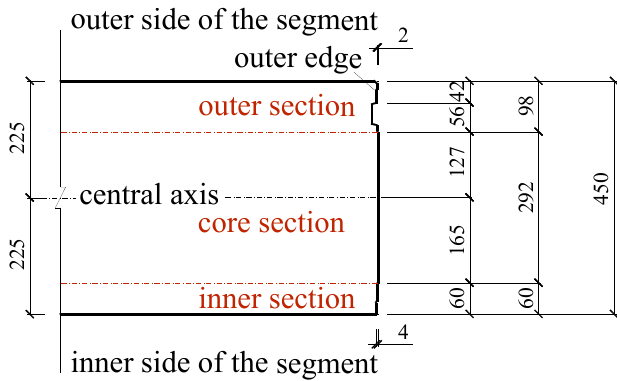
Figure 4. Geometric details of the joint section (unit: mm).